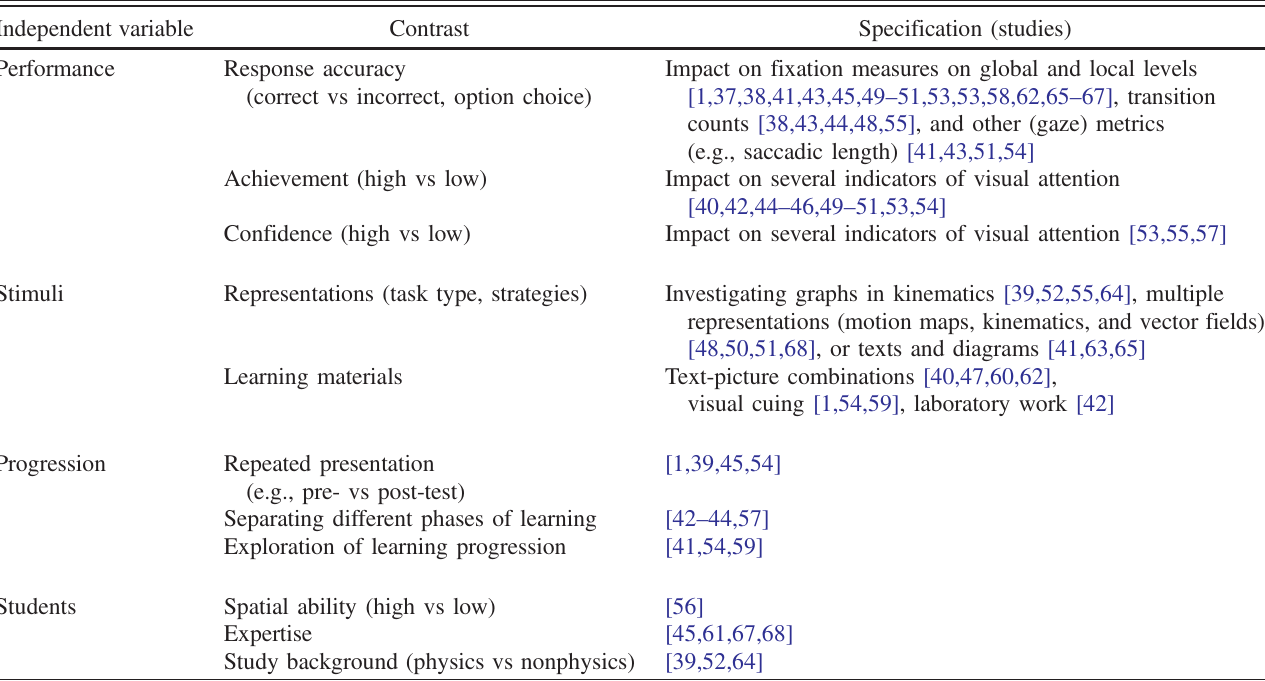
TABLE IV. Structuring the study results according to the split criteria used to analyze eye movements. Independent